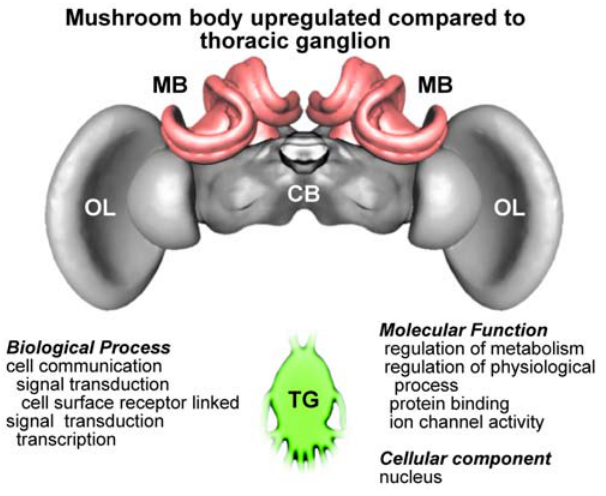
Figure 3. Results of GO enrichment analysis of genes that showed consistent differences in gene expression across the three honey bee species in the mushroom bodies compared to thoracic ganglion.